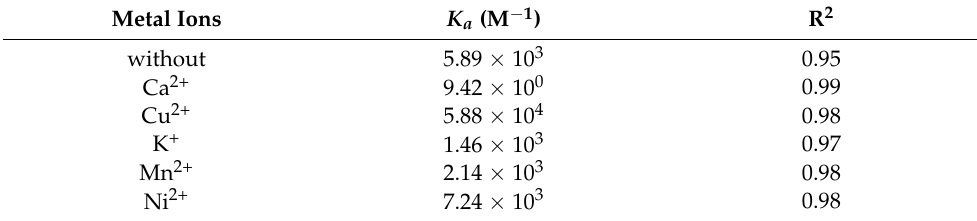
Figure 5. Double − logarithmic diagram of the CAPE–Hb system in the presence of five different metal ions at 298.2 K and in pH 7.4 buffer solution. The concentration of metal ions was fixed at 60 µ M. Table 5. Binding constants of the interaction between CAPE and Hb in the presence or absence of metal ions in 298.2 K and pH 7.4 buffer solution.